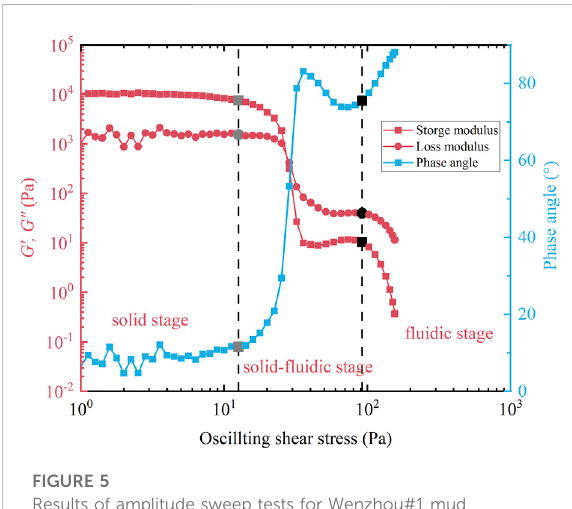
FIGURE 5 Results of amplitude sweep tests for Wenzhou#1 mud samples, the storage modulus G ′ , the loss modulus G ″ , and phase angle evolution with increasing oscillatory shear stress. In the fi gure, the grey point and the black point represent the fi rst yielding point and the second yielding point of the Wenzhou#1 natural mud sample,